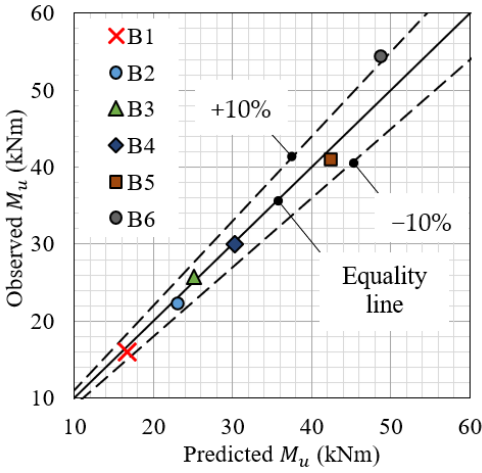
Figure 15. Predicted vs. observed 𝑀 𝑢 .